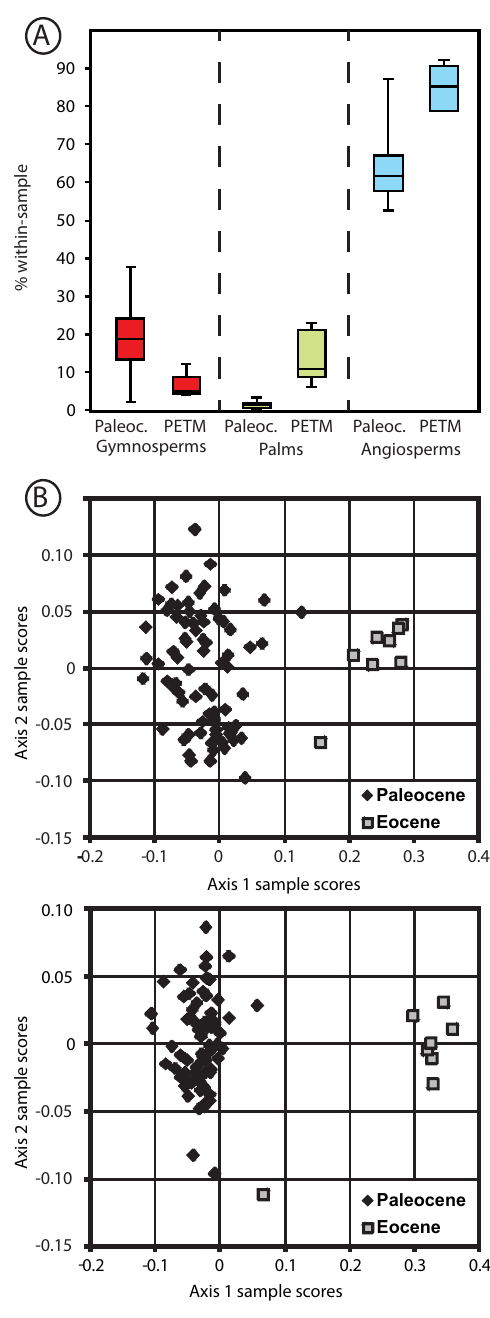
Figure 4. Pollen and spore results. (A) Box-plot comparisons be- tween average (mean) within-sample abundance of pre-PETM sam- ples ( n = 77) from Harrington and Jaramillo (2007) and PETM samples ( n = 8) from the Tuscahoma Fm of the Harrell Core. Abun- dances are expressed as average percent within sample. All compar- isons between pre-PETM abundances and PETM abundances are statistically significant. (B) Non-metric multidimensional scaling plots illustrating pollen compositional differences in the Tuscahoma Fm in the Harrell Core, based on the relative abundance data (top) and on presence–absence data (bottom). While the former reflects changes in dominant taxa, the latter is sensitive to changes in the co-occurrence patterns of taxa within